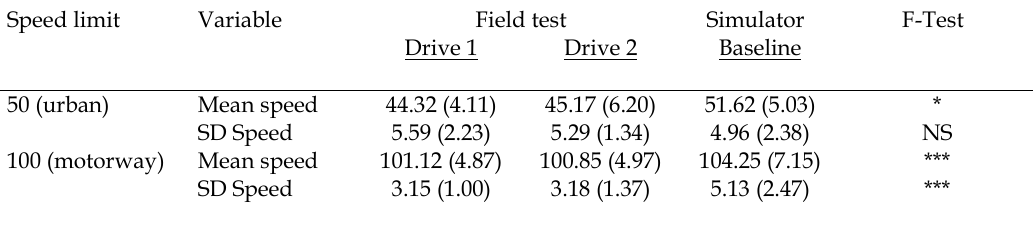
Table 4. Descriptive statistics of the measures regarding driving without specific secondary tasks.